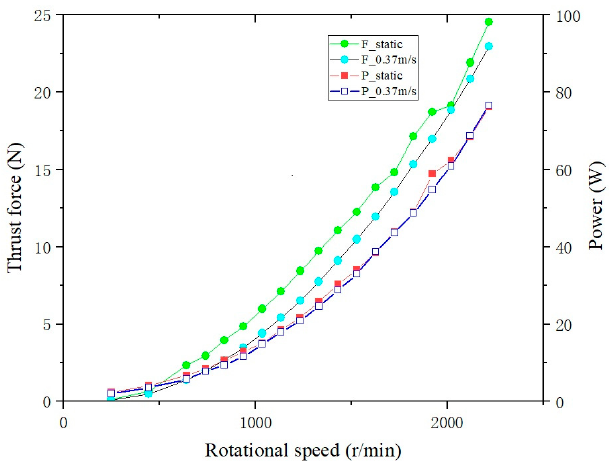
Figure 6. Thrust and power of the ducted propeller at different impeller rotational speed. The performance curves of the ducted propeller under the impeller rotating speed of 2000 r/min are shown in Figure 7. It can be seen that the thrust of the propeller decreases gradually with the increase of the navigational speed. The propulsion efficiency increases first, reaching the highest point when the navigational speed is about 1.54 m/s, and then it decreases when the navigational speed accelerates further. The trend is basically consistent with the existing theory of the ducted propeller.